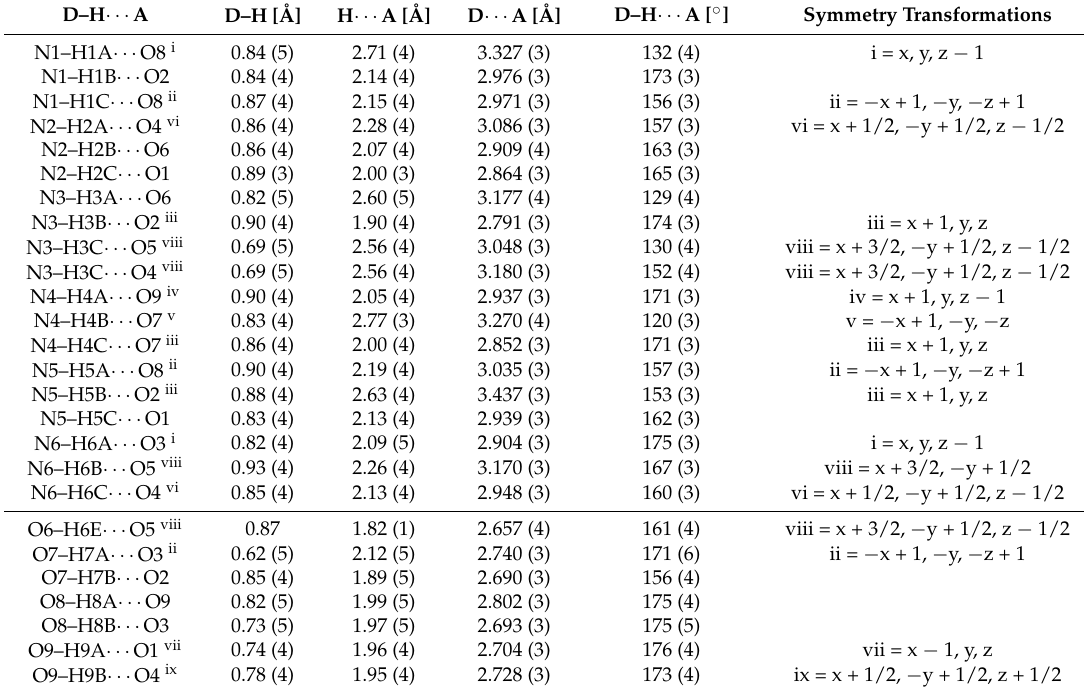
Table 4. Details of the hydrogen bonding interactions in 2 a